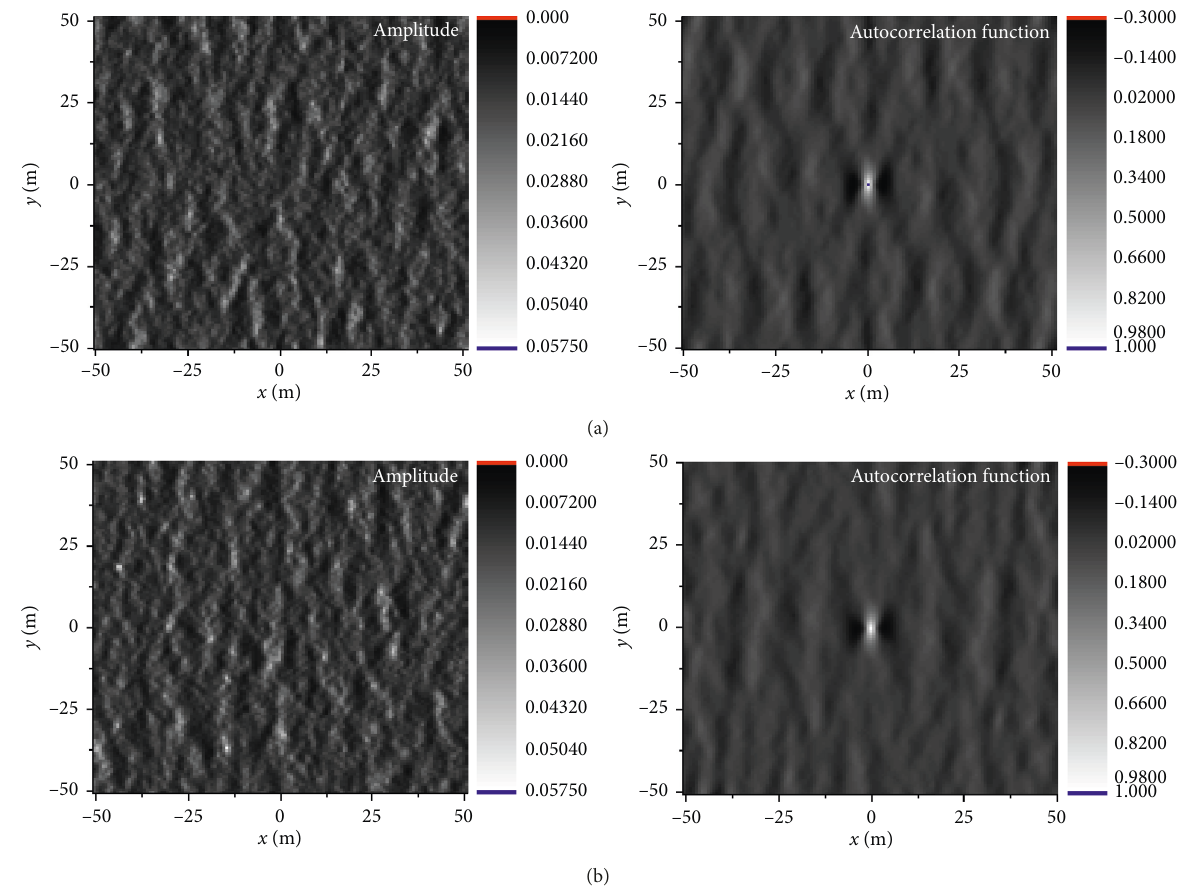
Figure 2: Comparisons of amplitude and autocorrelation function of 2D sea clutter generated by statistical and EM models. (a) Statistical model. (b) EM yOt plane, respectively. It is seen from Figure 6 that the Figure 6 gives the amplitude and autocorrelation amplitude and autocorrelation function in different planes function of 3D temporal-spatial correlated sea clutter gen- have different textures. Figure 7 shows the comparison of 1D erated by the statistical model in xOt plane, xOy plane, and